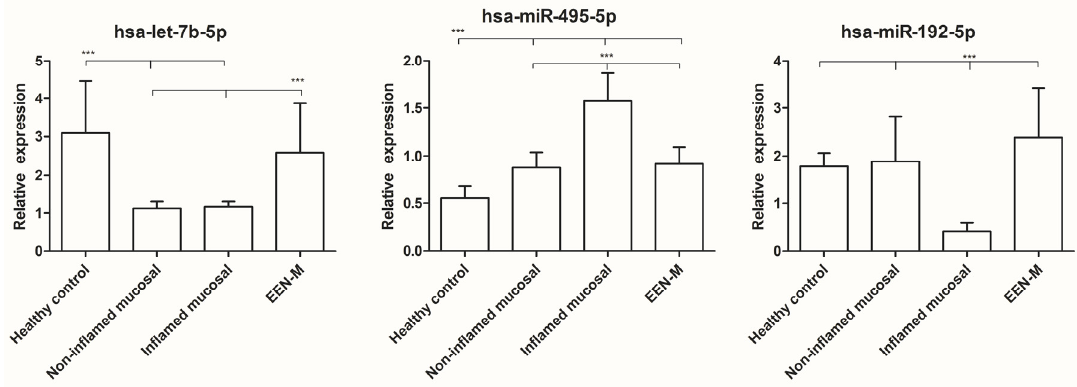
Figure 5. Expression of four miRNAs in all groups. *** p < 0.0001.